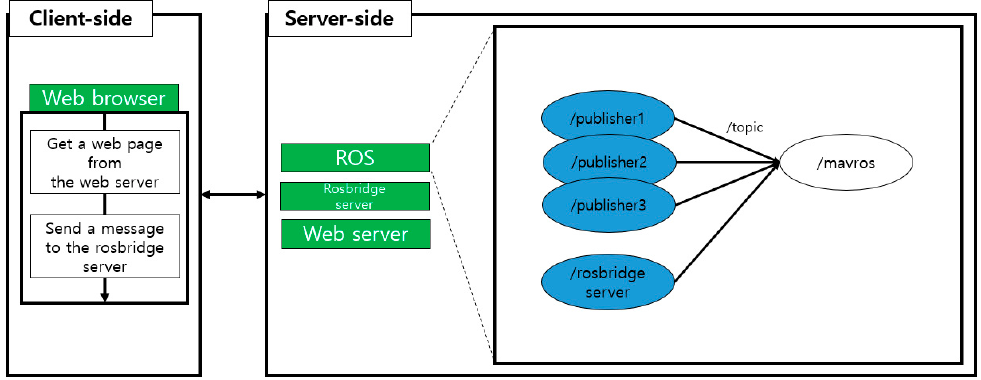
Figure 16. Rosbridge diagram.